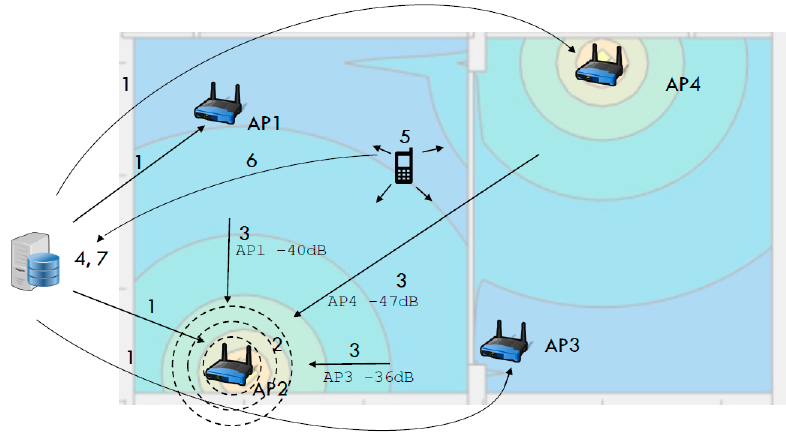
Figure 1. High-level overview and main steps in the proposed localization schema.